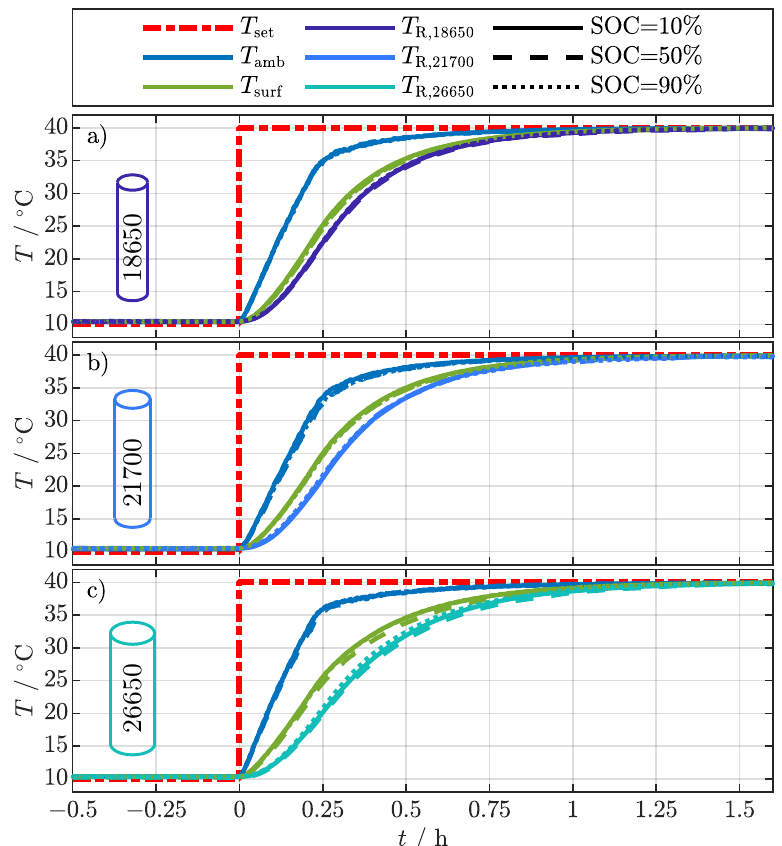
Figure 4. Temperature development during the external temperature change from 10°C to 40°C for the different cell formats 18650 ( a ), 21700 ( b ), and 26650 ( c ) at the investigated SOC of 10%, 50%, and